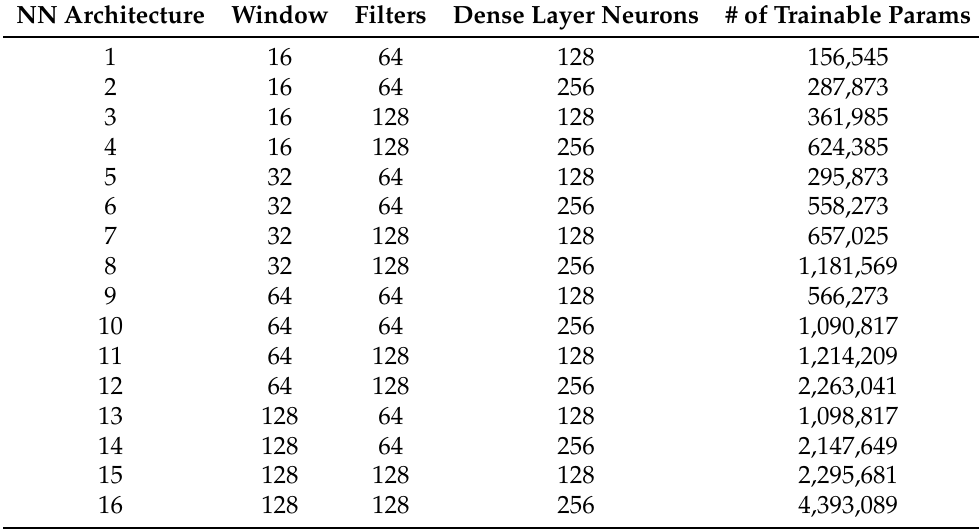
Figure 7. The architecture of the deep neural network with dilated casual 1D convolutions used in the current study. Here, features refers to the number of sensors (three in the case of the present study). And, asterisk refers to multiplication. Table 2. Neural network architectures based on the parameters described in Table